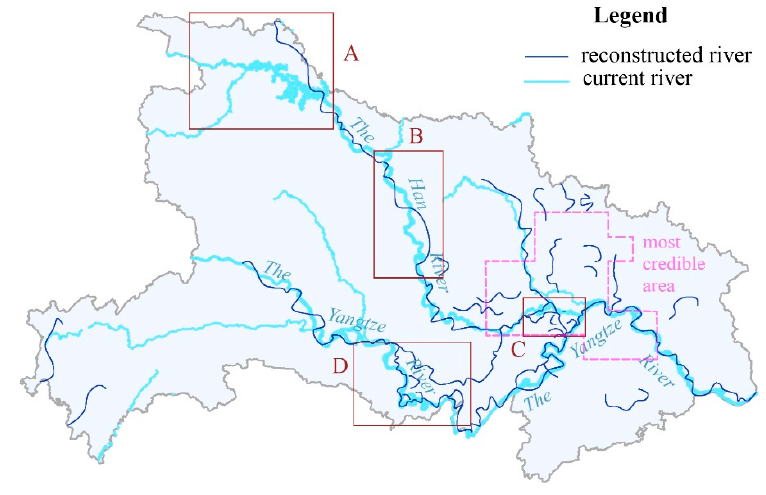
Figure 8. Reconstructed results for first- and second-level rivers.